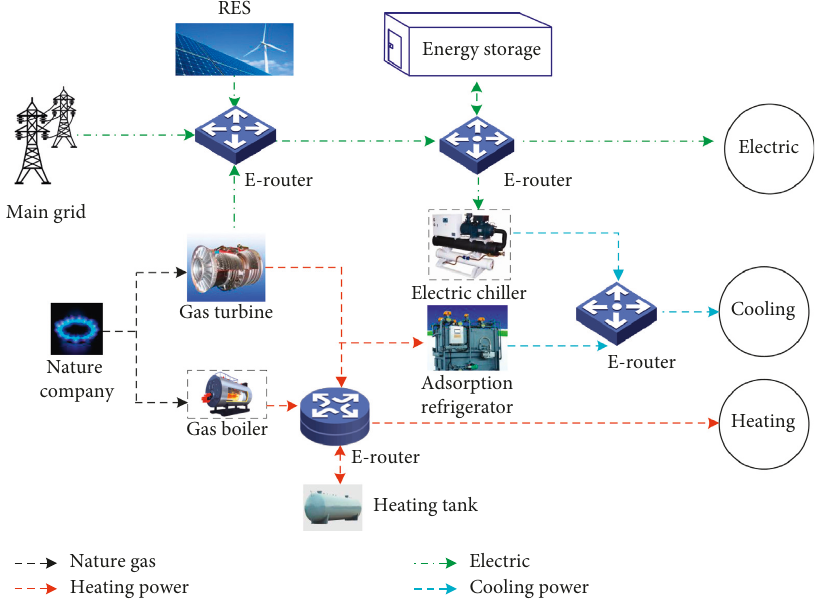
Figure 1: The typical architecture of ELN